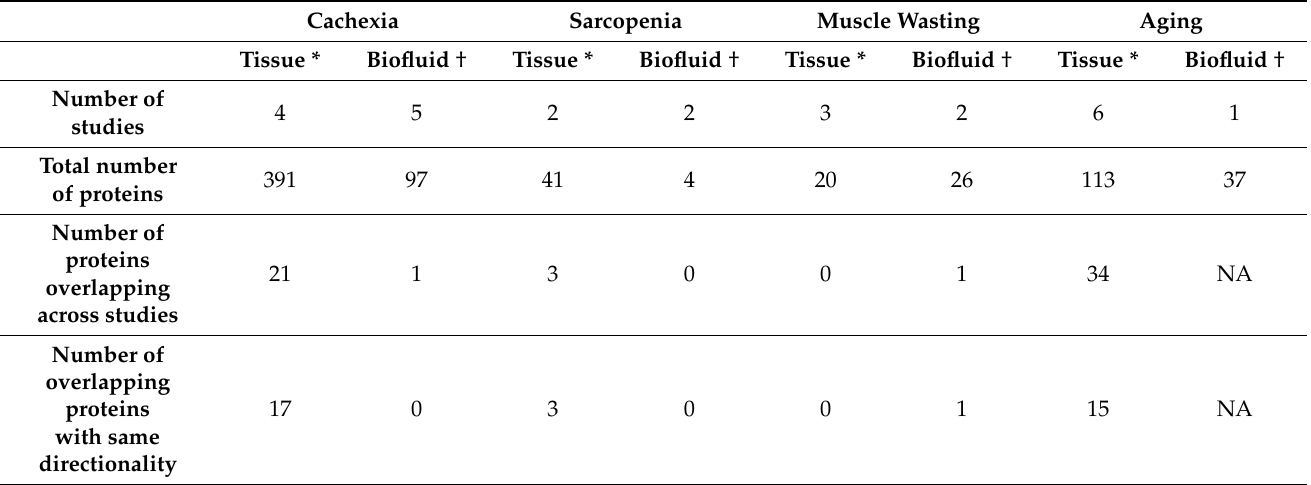
Table 2. Overlap of proteins found up- and/or downregulated across studies, per muscle condition and tissue or biofluid